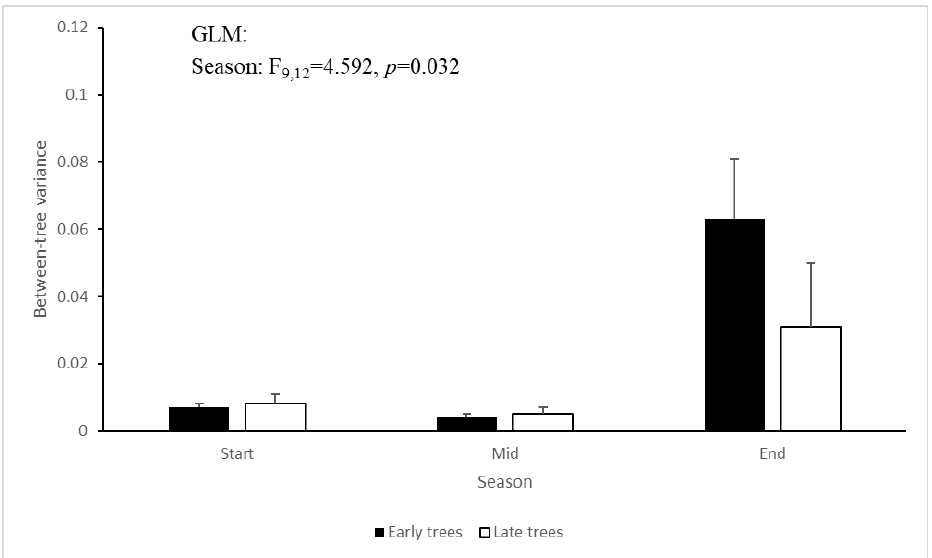
Figure 3. Among-tree variance of the proportion of male-phase flowers in the ‘Early’ and ‘Late’ flowering morphs along the flowering season. Error bars indicate the between-year standard errors.